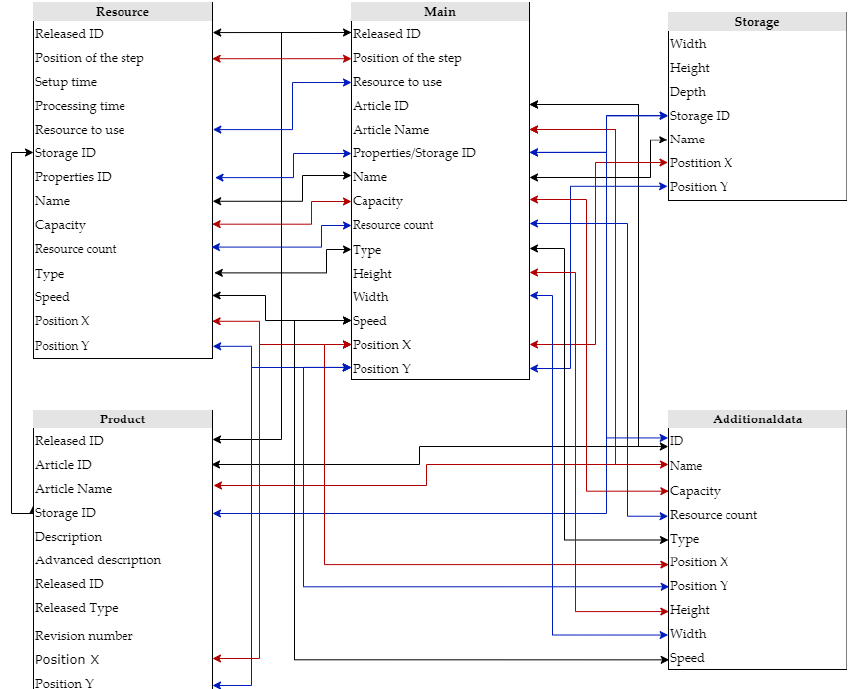
Figure 4. Relationship between the agents and the data.